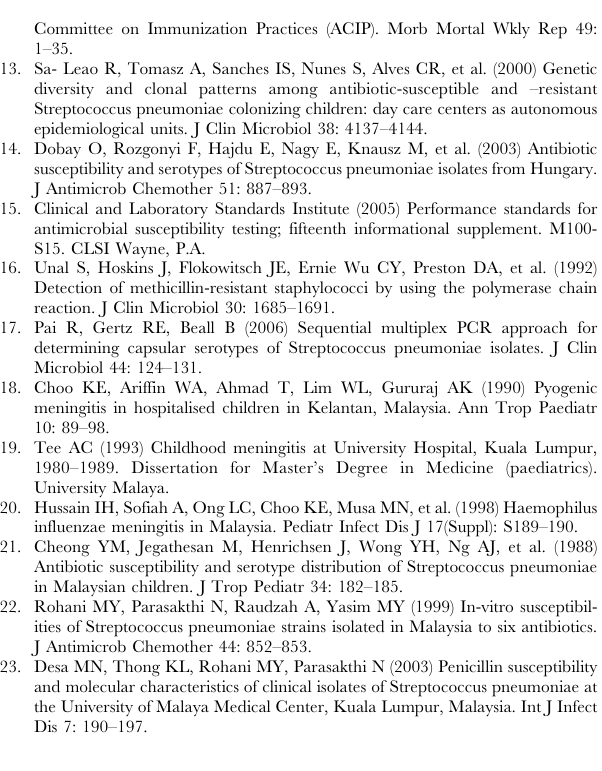
Table S1 The concentrations of primers used in seven multiplex PCR